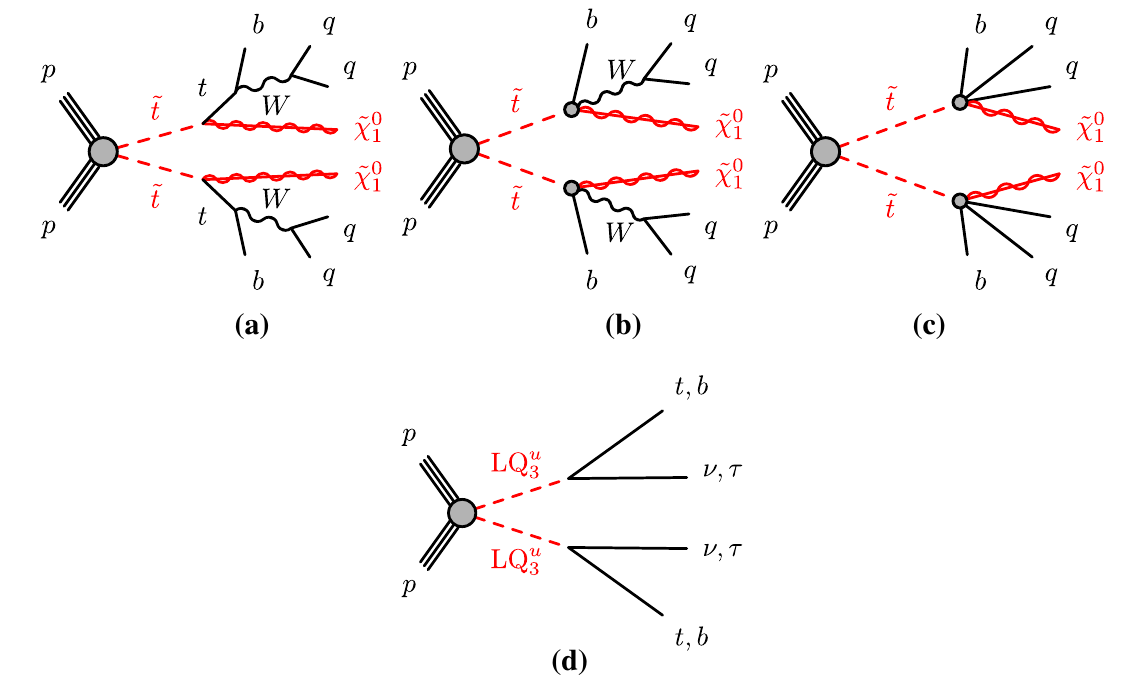
Fig. 1 Decay topologies of the signal models considered in the anal- ysis: a two-body, b three-body, c four-body top squark decays, the top quarks being produced in pairs, and d up-type, third-generation scalar leptoquark pair production, with both leptoquarks decaying into a top